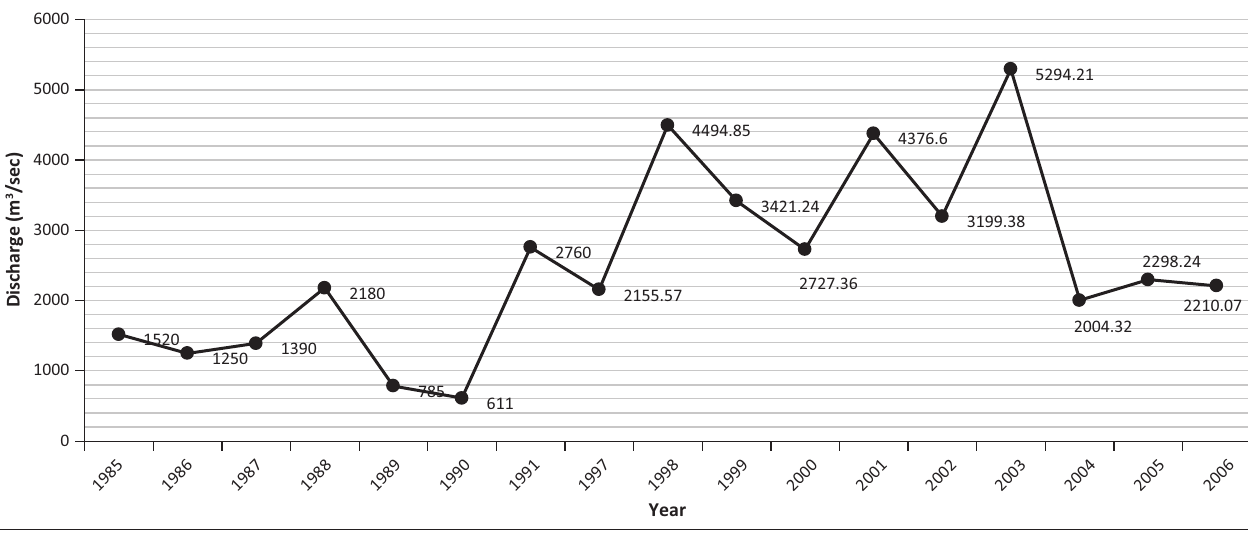
FIGURE 6: Yearly recorded maximum discharge at Dalia Station from 1985 to 2006.